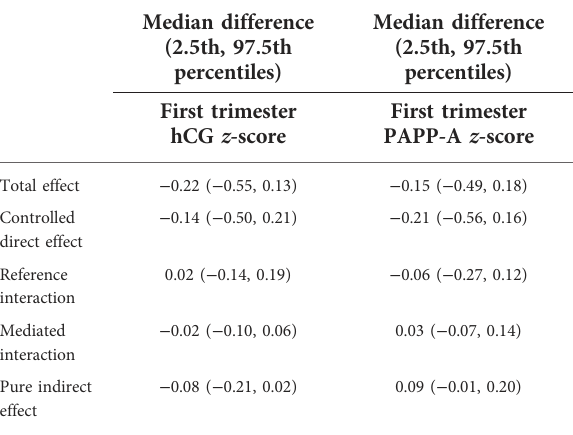
TABLE 4 Differences in the decomposition results between female and Male infants, for fi rst trimester placental biomarkers